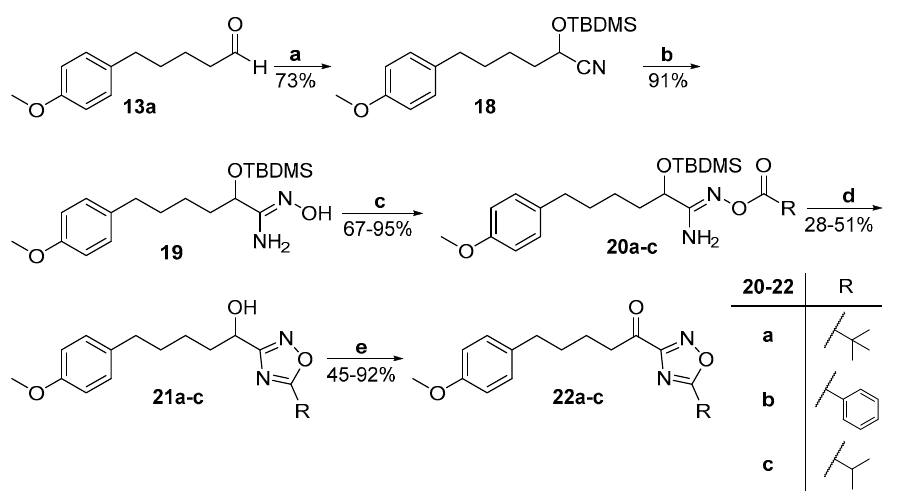
Figure 7. Synthesis of α -keto-1,2,4-oxadiazoles 22a – c . (a) TBDMSCN, KCN, 18-crown-6, dry CH 2 Cl 2 ; (b) 50% aq. NH 2 OH, microwave irradiation 50 W, 120 °C; (c) pivalic acid (for pivalate group) or benzoic acid (for benzoate group) or isobutyric anhydride (for isobutyrate group), DCC, dry CH 2 Cl 2 ; (d) TBAF, toluene, microwave irradiation 90 W, 120 °C; (e) Dess–Martin periodinane, CH 2 Cl 2 .